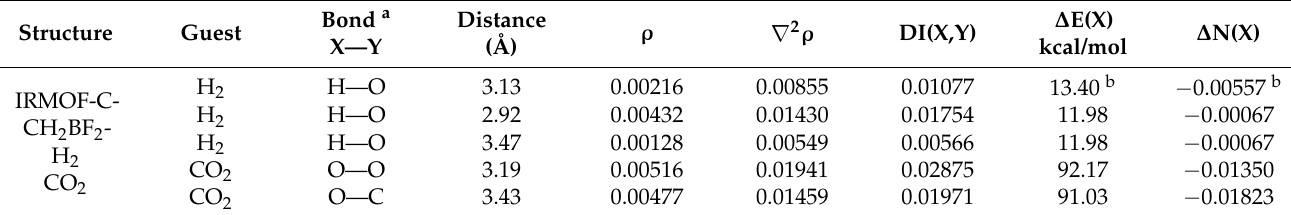
Table 14. Topological parameters of the BCP of bond in adsorption configurations of guest molecules (CO 2 and H 2 ) on IRMOF-C-CH 2 BF 2